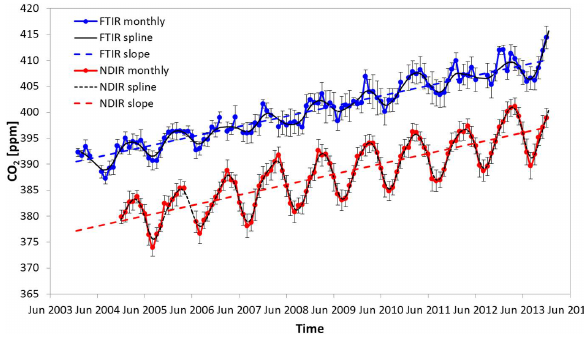
Figure 4. FTIR and NDIR CO 2 measurements at JFJ as a function of time: monthly averages of the filtered FTIR data (blue), spline (black line), the annual CO 2 increase calculated from the filtered FTIR data set (blue dashed line), monthly averages of the filtered NDIR data (red), spline (black dotted line), and the annual CO 2 in- crease calculated from the filtered NDIR data set (red dashed line).